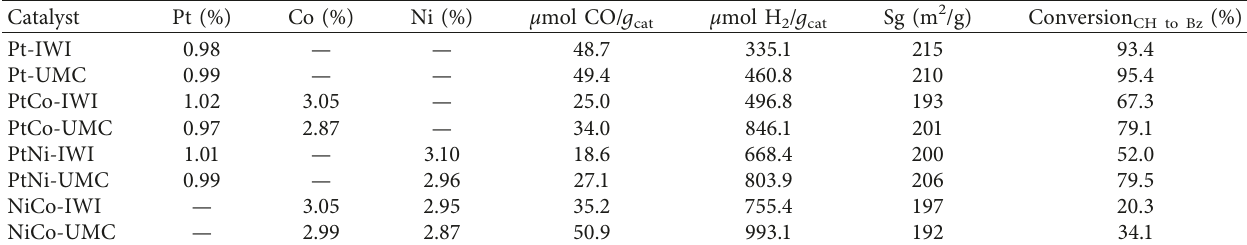
2 consumption in TPR test, and specific surface area (Sg).